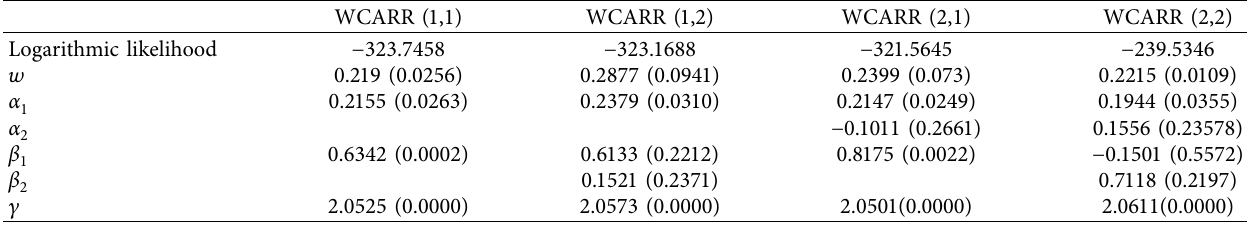
Table 3: Comparison of different lag order estimation results of the WCARR model based on B segment weekly data.